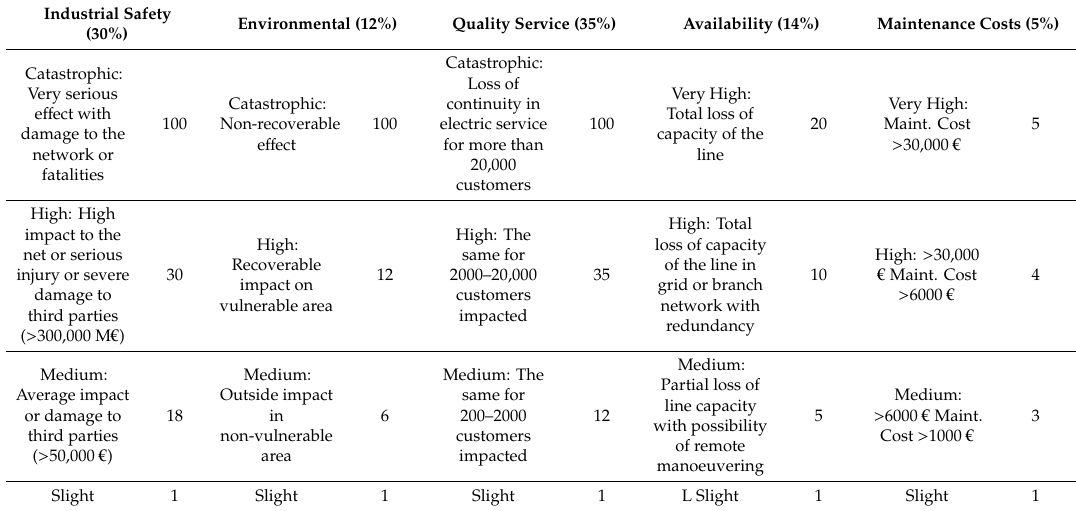
Table 3. Failure severity criteria and levels used in the power lines example.